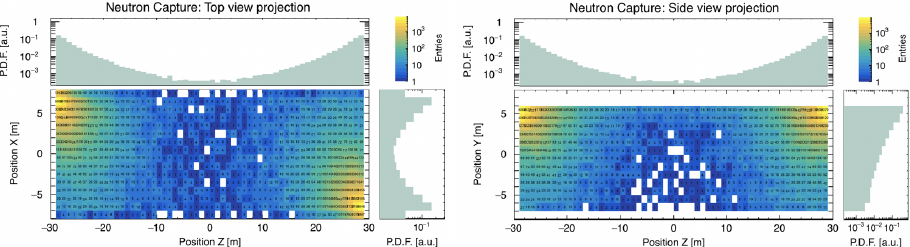
Figure 9. Simulations of spatial distribution of neutron captures in the DUNE far detector, from two pulse neutron sources located externally, at the top of the detector in two opposite corners. From